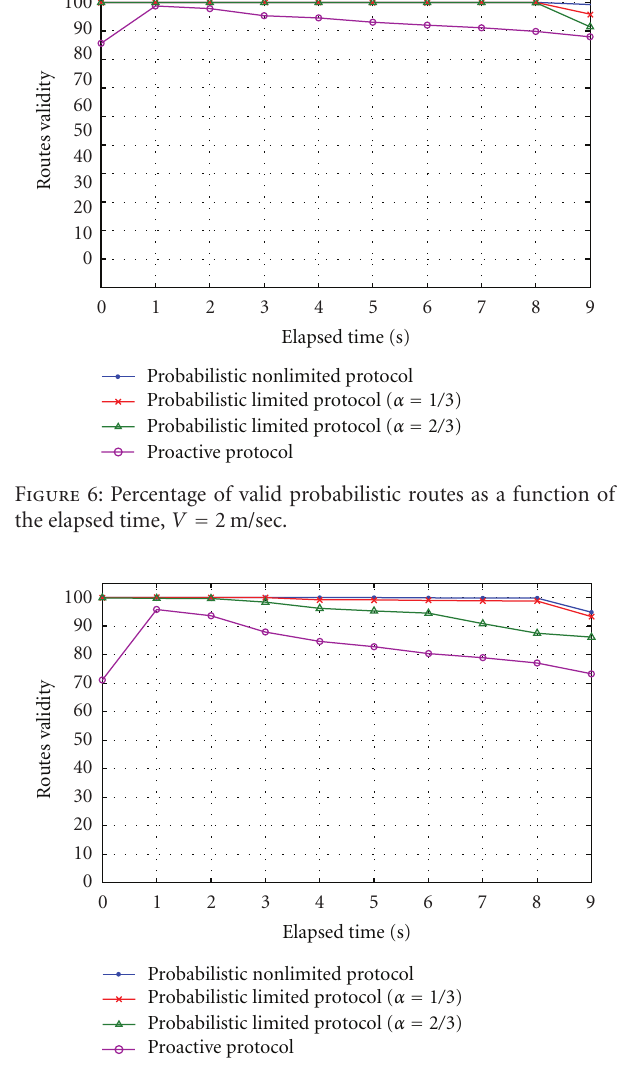
Figure 7: Percentage of valid probabilistic routes as a function of the elapsed time, V =